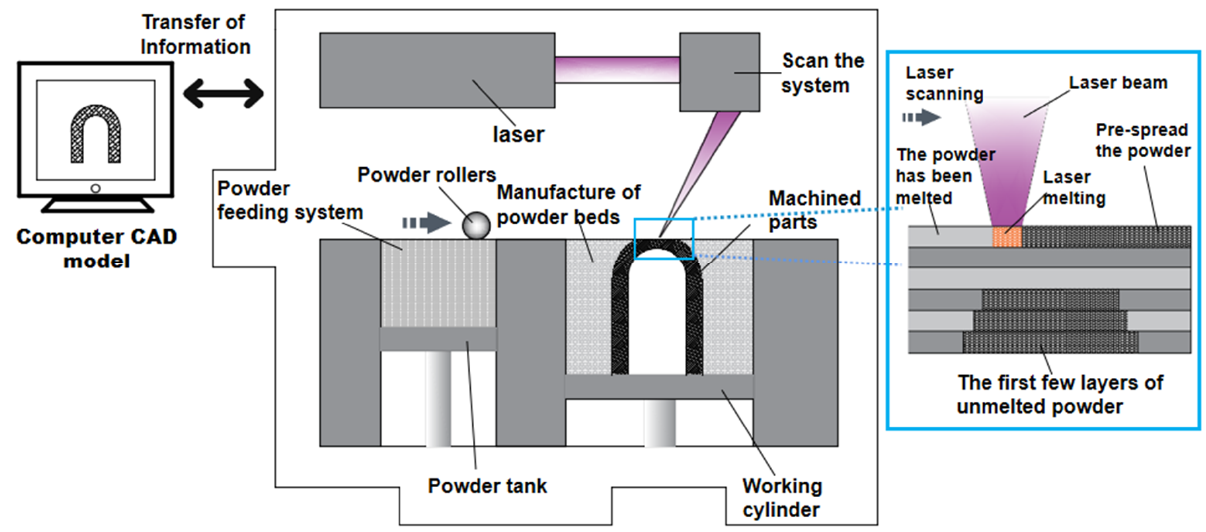
Figure 1. Schematic diagram of the basic principles of SLM technology.